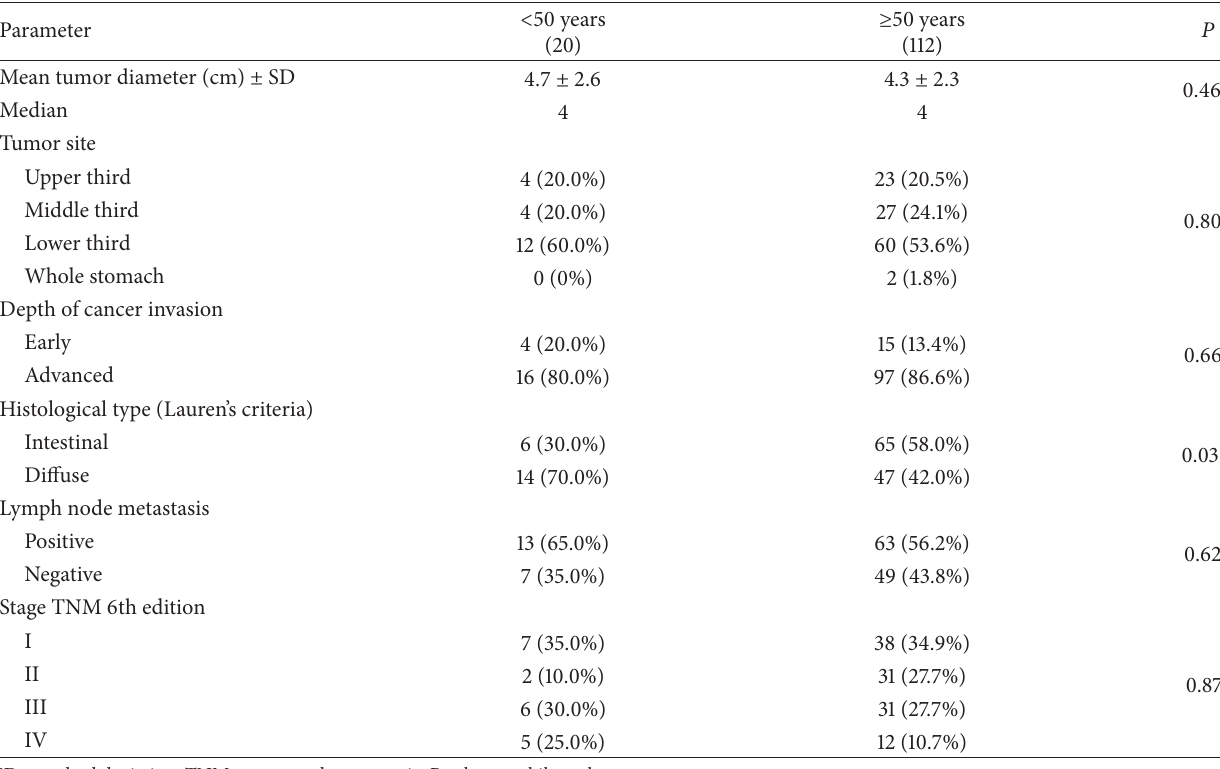
Table 2: Pathologic characteristics of operated gastric tumors.